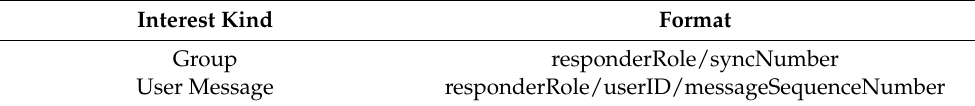
Table 1. Emergency group communication